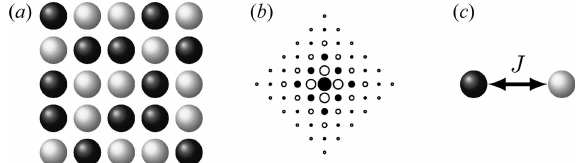
Figure 1 Descriptions of complex structures, illustrated for the case of a disordered binary alloy. ( a ) A representative atomistic configuration. ( b ) The auto- correlation function, with positive maxima represented by filled circles and negative maxima by empty circles. The size of the circle corresponds to the strength of the auto-correlation. ( c ) The interaction space driving the generation of atomistic models as in panel ( a ) and the corresponding auto-correlation function in panel ( b